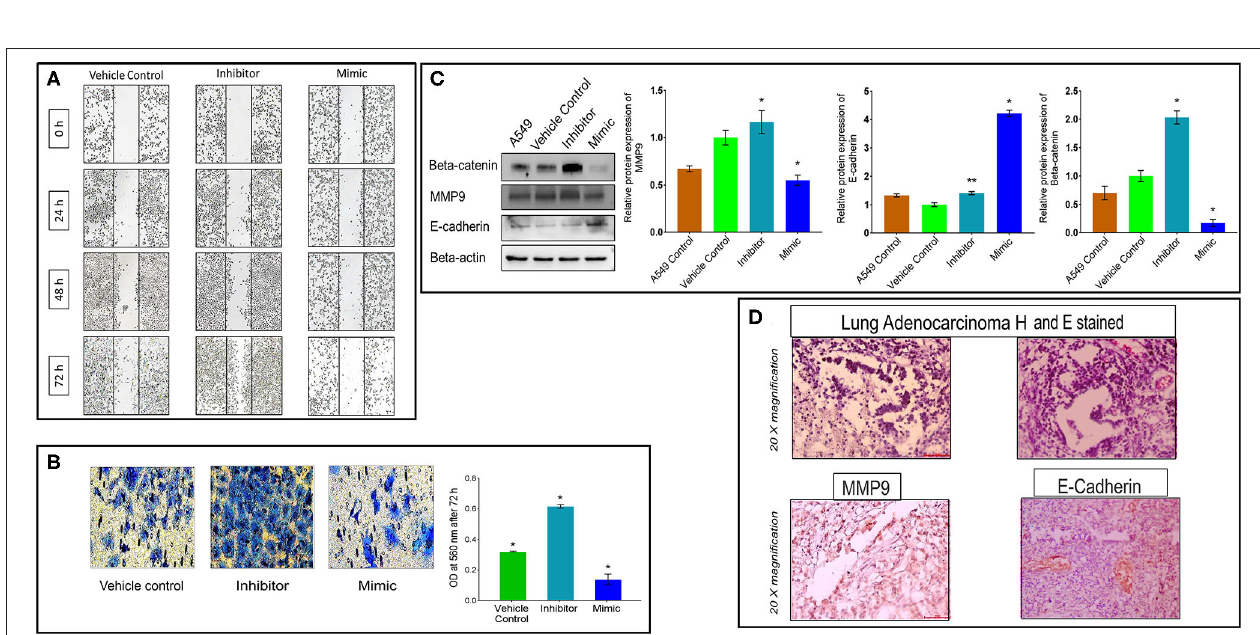
FIGURE 5 | MiR-320a promotes A549 cell migration, invasion, and EMT. (A) Cell migration assay in A549 cells transfected with the vehicle control, a miR-320a inhibitor (100nM), or mimic (100nM) at 0, 24, 48, and 72h post transfection. (B) Cell invasion assays in A549 cells at 72h post transfection with the vehicle control, a miR-320a inhibitor (100nM), or mimic (100nM). Experiments were performed three independent times. Bar graphs are presented as mean ± SEM where * p > 0.01, ** p < 0.001 calculated using paired t- test. (C) Immunoblot assays (a representative blot is shown) were used to determine normalized protein levels of EMT regulated proteins; Beta-catenin, MMP9, and E-cadherin in untransfected A549 cells, A549 cells transfected with the vehicle control, a miR-320a inhibitor (100nM), or mimic (100nM). All experiments were carried out four independent times. The data are presented as mean ± SEM where * p > 0.05, ** p < 0.05 significant differences from vehicle control calculated using paired t -test. (D) Immunohistochemistry images represent tumor cells positive (brown-stained) for MMP9 and E-cadherin proteins in the cytoplasm, and/or the cell membrane of NSCLC patient tissue samples. Scale bar 100 µ m and n = 3 NSCLC tissues.